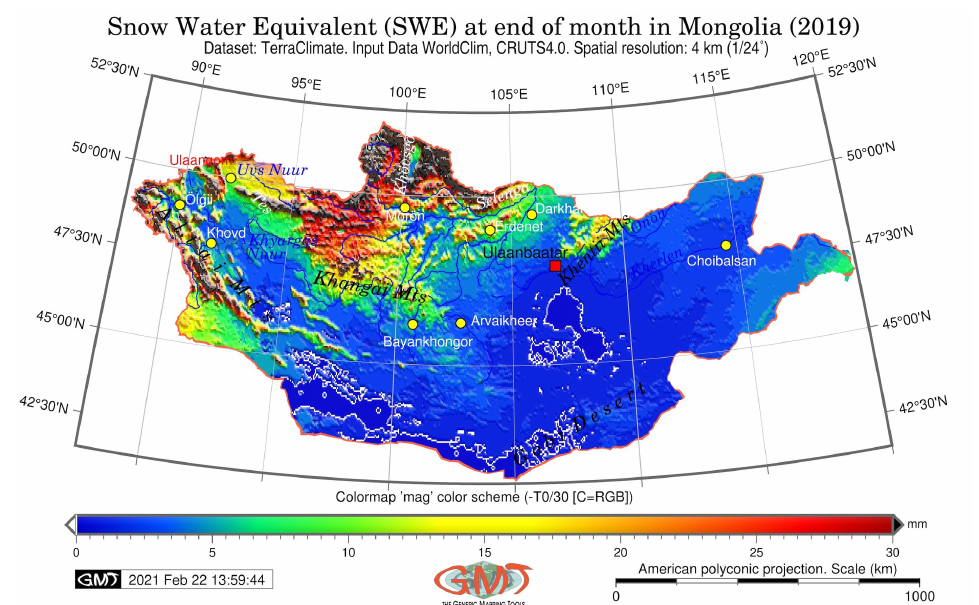
Figure 7. Snow water equivalent in Mongolia in 2019. Mapping: GMT by script available in Appendix B.6. Source: author.